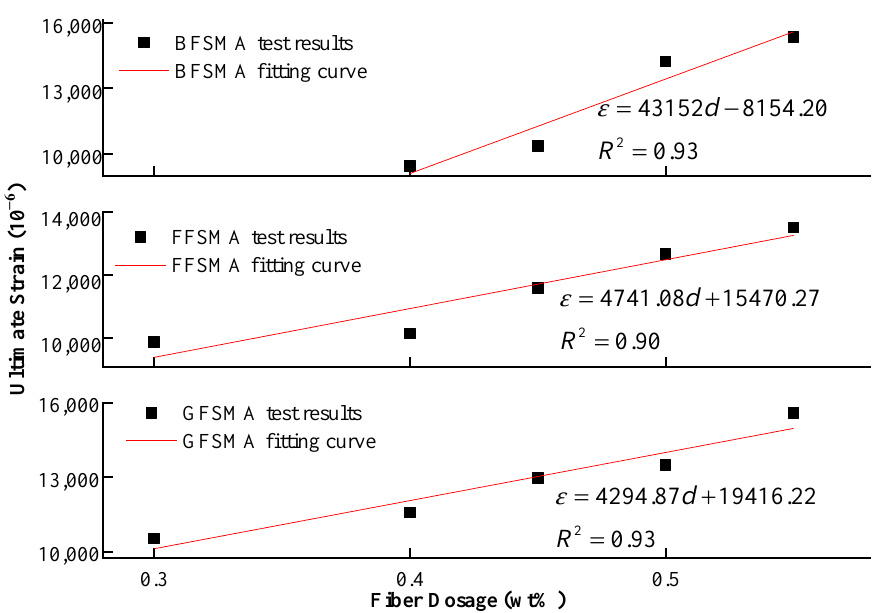
Figure 8. Fitting between fiber dosage and ultimate strain.